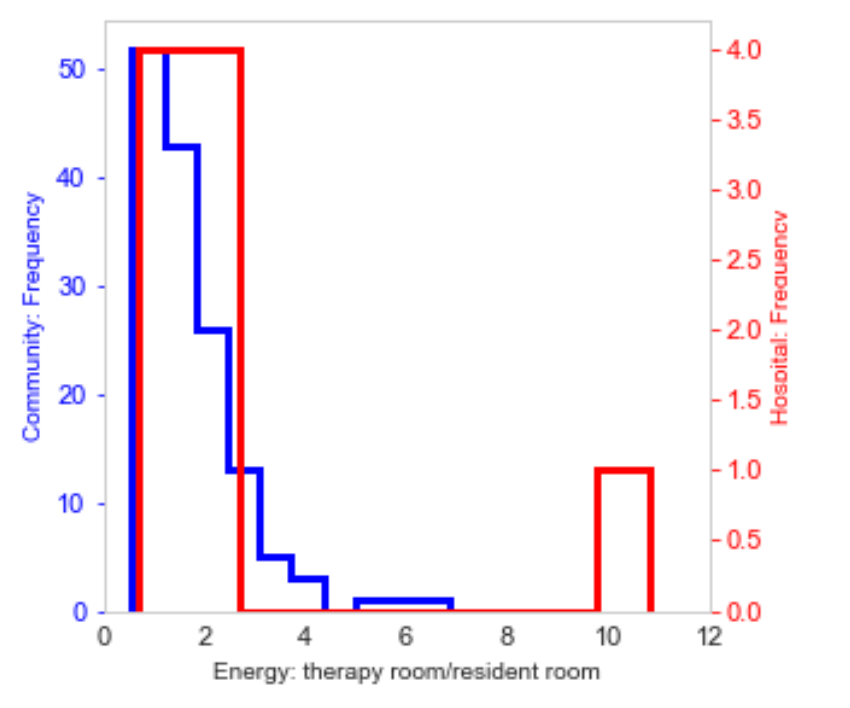
Figure 7. Distribution of patients spending energy in therapy room compared with resident room. X-axis indicates the ratio of energy in therapy to resident room.